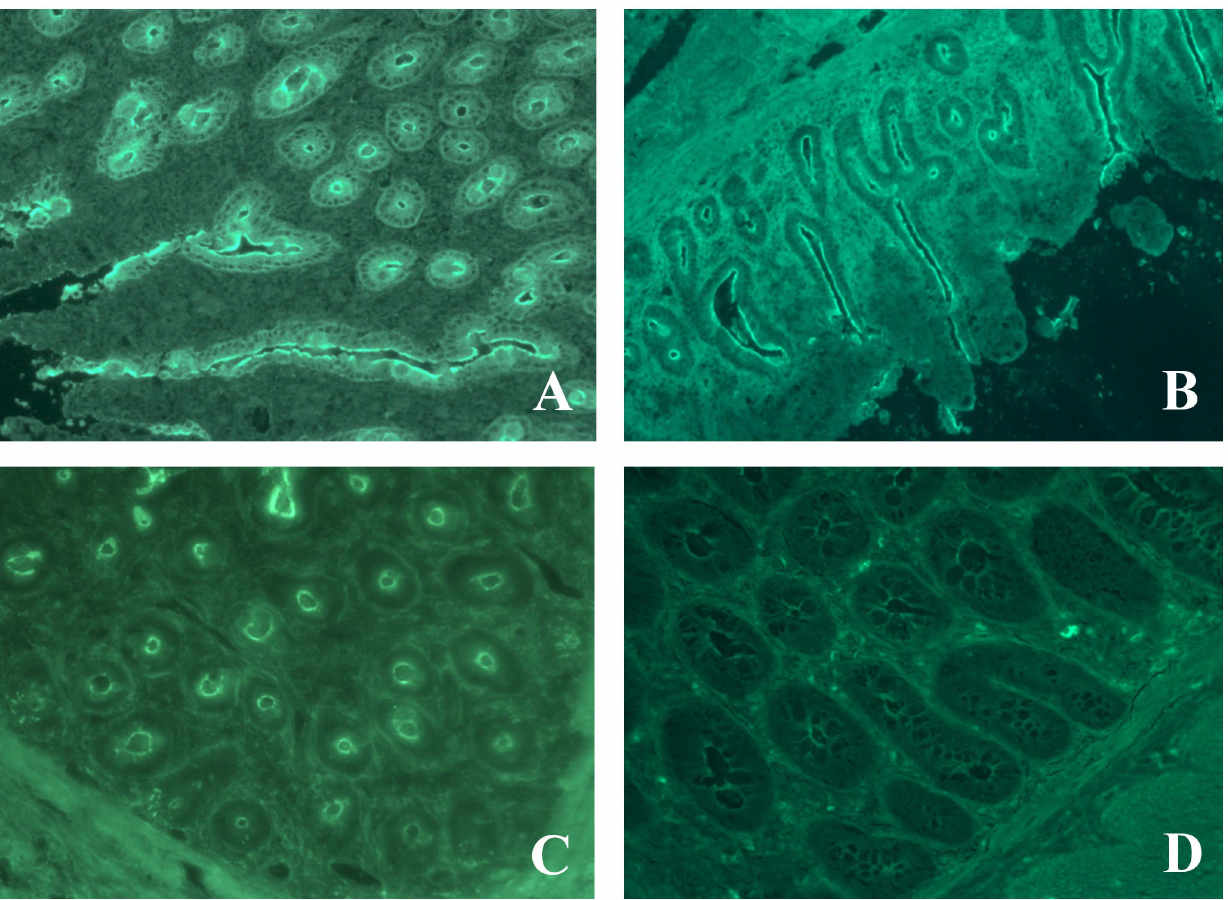
Figure 2. Immunofluorescent staining of intestinal enterocytes with patients’ sera. HAA from IPEX Pt 19 bind the brush border and cytosol of enterocytes (panel A) while VAA from IPEX Pt 17 binds only the brush border (panel B). IgG from PID Pt L1 bind the enterocytes brush border (panel C). Absence of binding in IPEX-like Pt L30 (panel D).